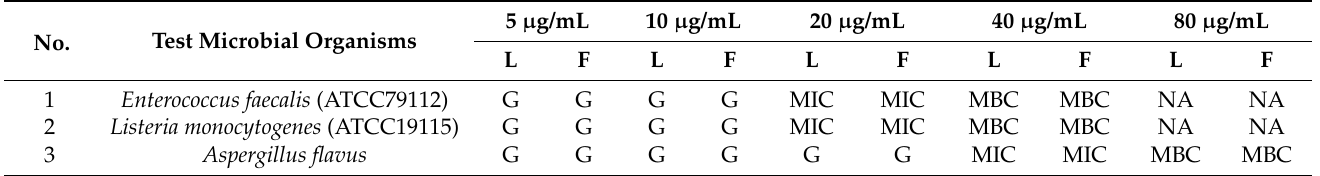
Table 6. Results of minimum inhibition concentration (MIC) of